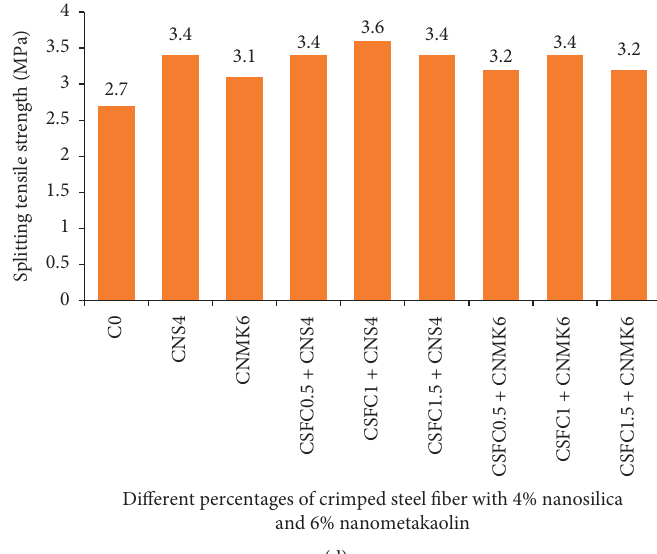
Figure 8: Splitting tensile strength for (a) GPC containing nanosilica, (b) GPC containing nanometakaolin, (c) different % of hooked-end steel fiber reinforced GPC containing 4% nanosilica, and (d) different % of hooked-end steel fiber reinforced GPC containing 6%